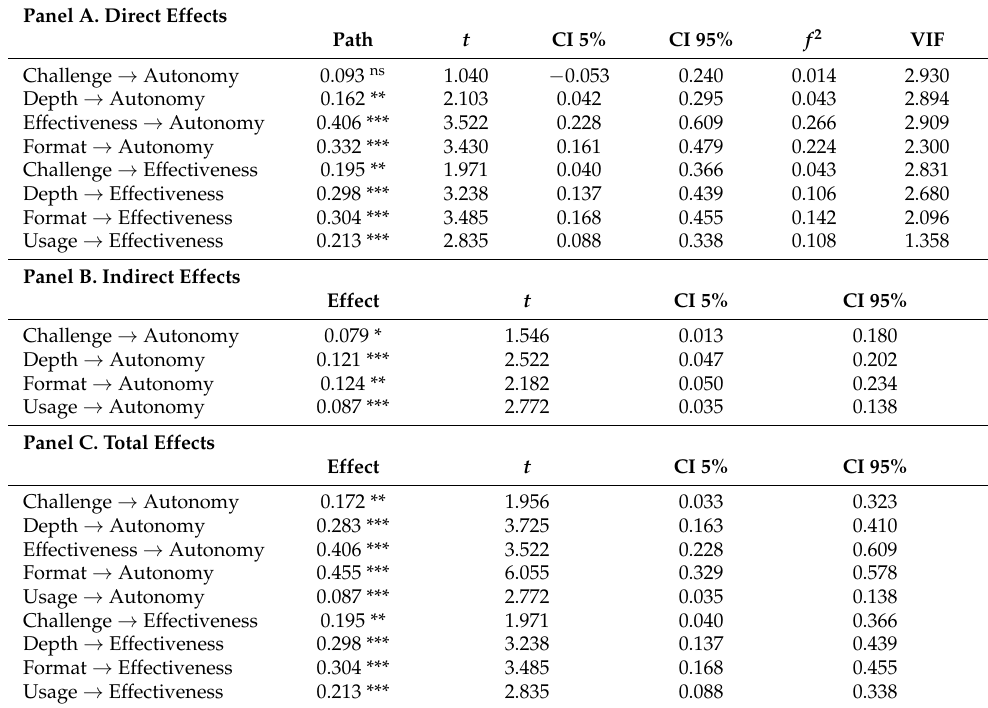
Table 5. Valuation of the Structural Model. Panel A. Direct Effects